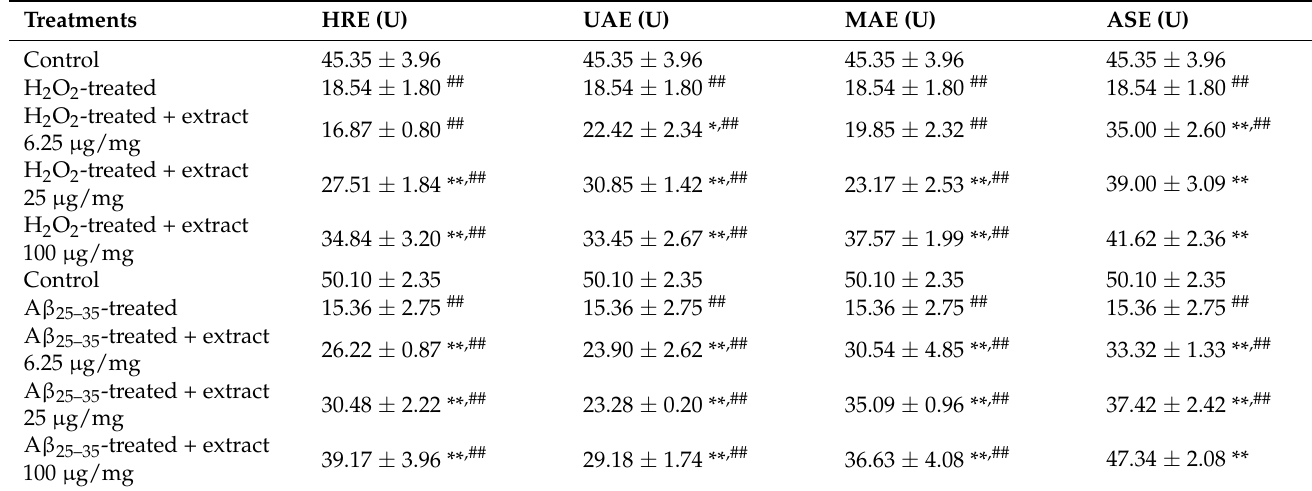
Table 7. Effects of Gardeniae fructus extracts on GSH-Px activity of H 2 O 2 - or A β 25–35 -treated PC12 cells (mean ± SD, n = 3).